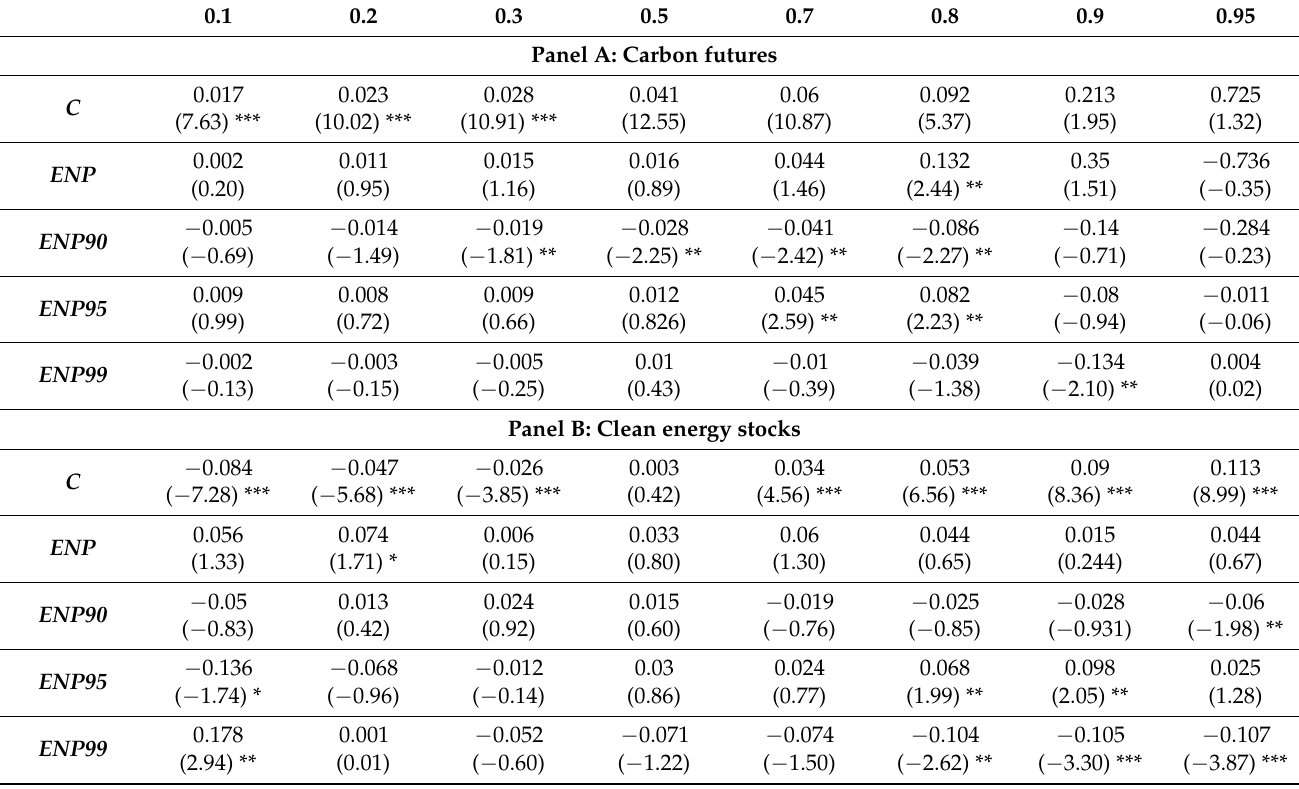
Table 6. Robustness checking with environmental policy